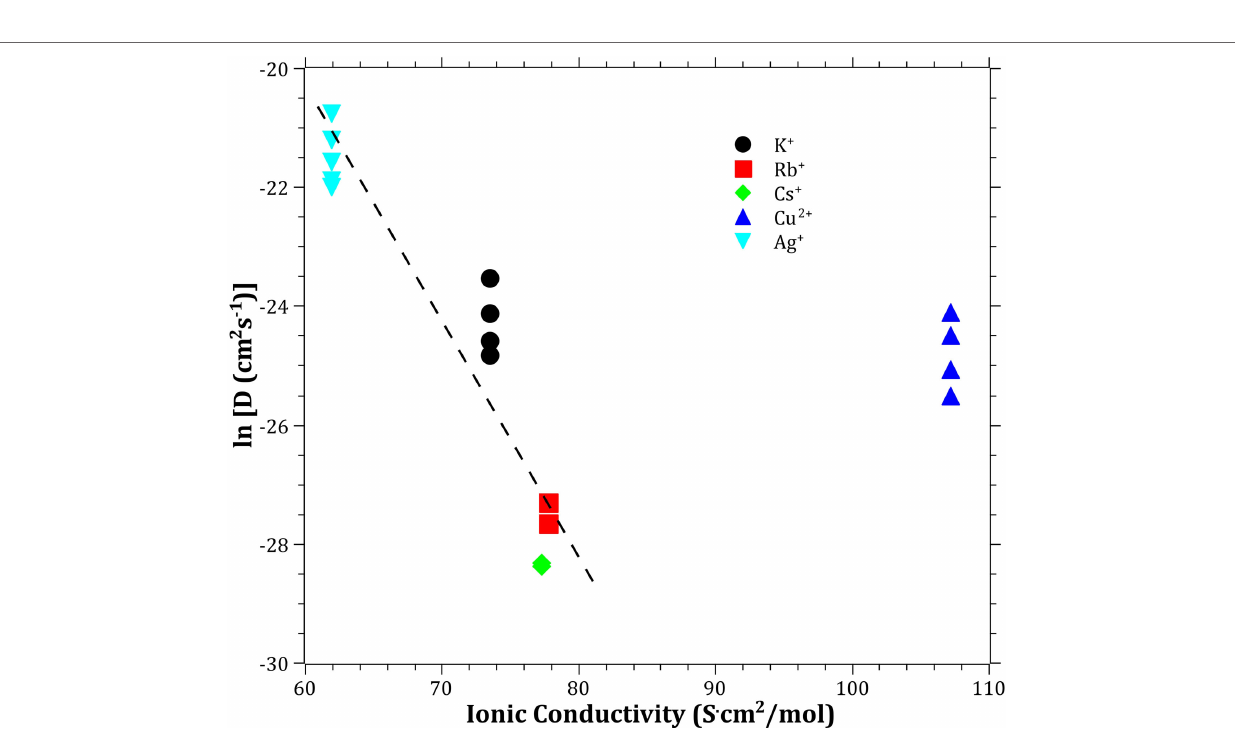
FiGUre 9 | Logarithm of the effective diffusion coefficient vs. aqueous ionic conductivity . Data taken from Dean (1999). The dashed line is a guide to the